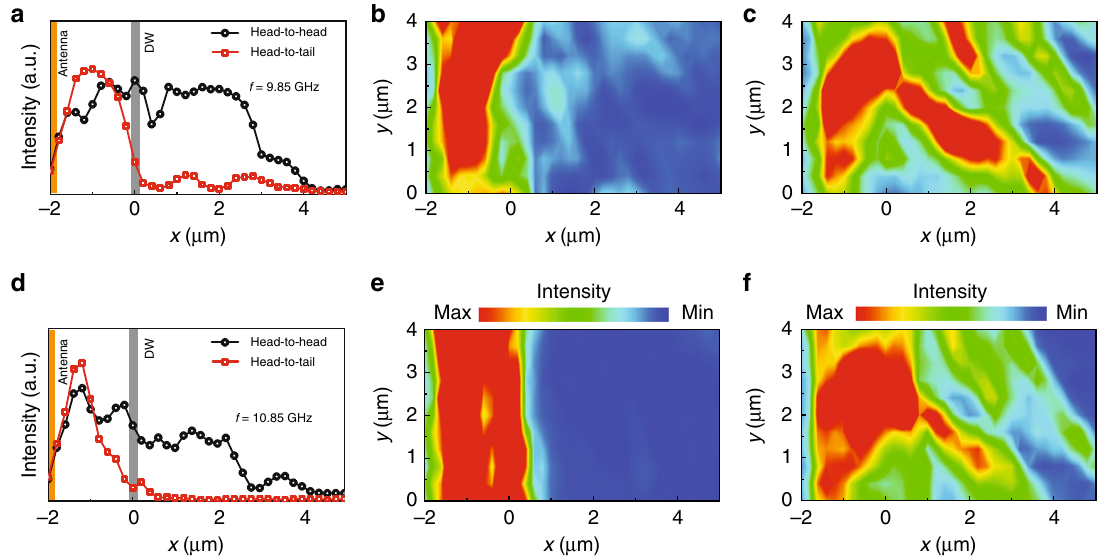
Fig. 3 Frequency and spatial dependence of spin-wave transmission. Line scans and areal maps of BLS intensity recorded from the antenna edge across the pinned domain wall at excitation frequencies of 9.85 GHz ( a – c ) and 10.85 GHz ( d – f ). The areal maps in b , e are recorded after the magnetization con fi guration is set to a head-to-tail domain wall. The maps in c , f show BLS intensity data for a head-to-head domain